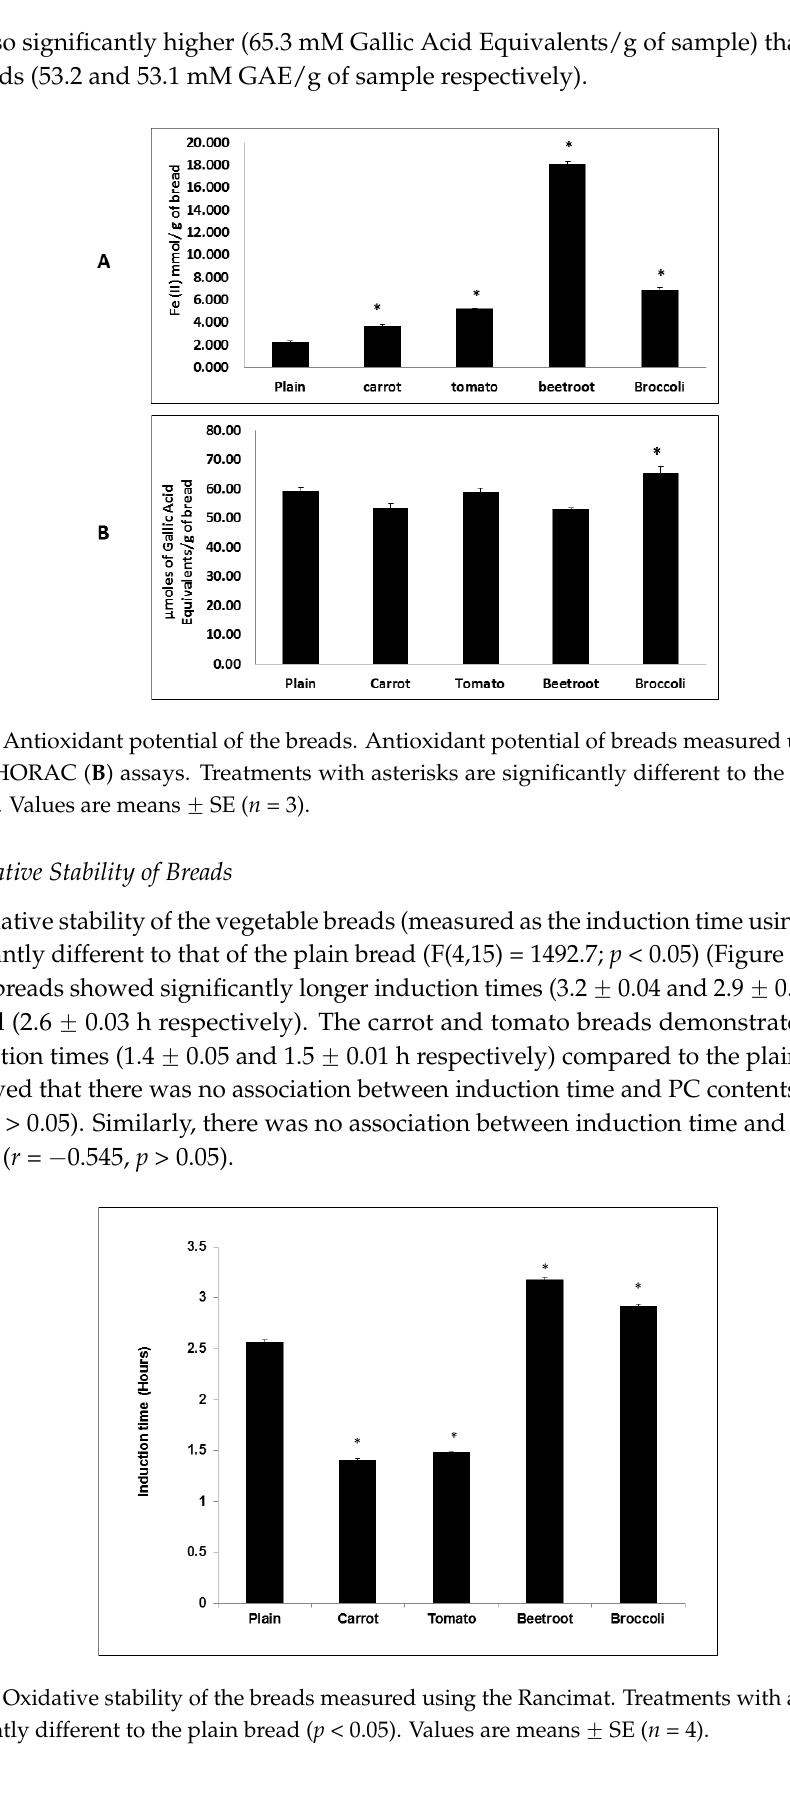
Figure 2. Oxidative stability of the breads measured using the Rancimat. Treatments with asterisks are significantly different to the plain bread ( p < 0.05). Values are means ± SE ( n = 4).